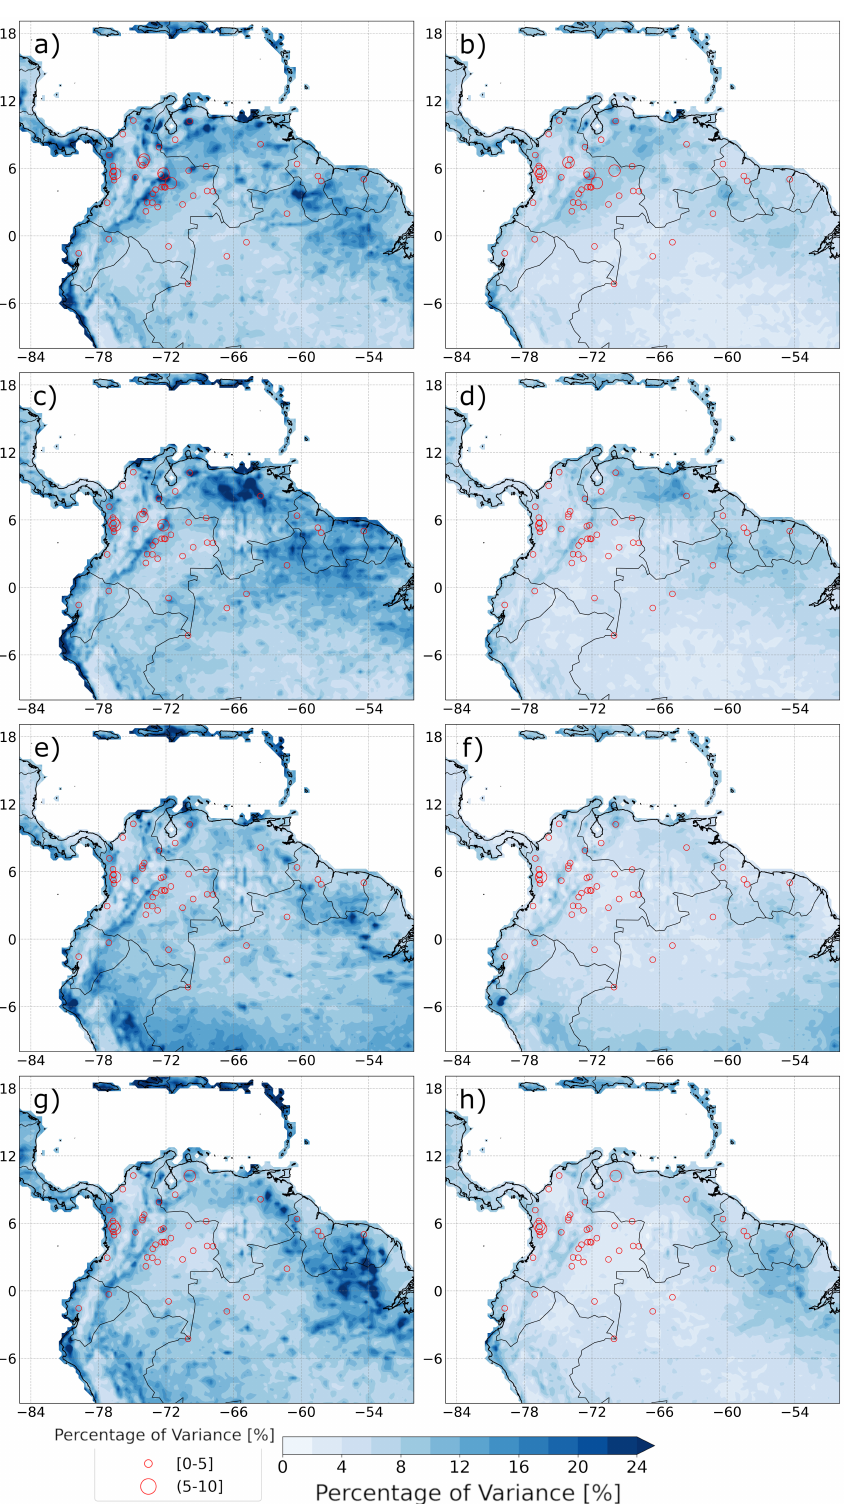
Figure 8. Seasonal percentage of variance explained by the SMV for daily precipitation over the region of study, and streamflows over each catchment (red circles). (left column) IMF2 and (right column) IMF3. ( a , b ) DJF; ( c , d ) MAM 2; ( e , f ) JJA 3; ( g , h )